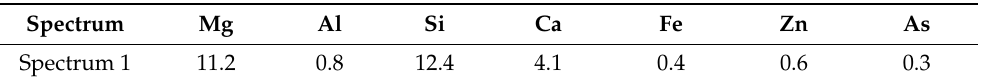
Table 3. Elements detected through EDS analysis of the areas shown in Figure 6a. Results are reported in weight percentage (w%) removing the counts of oxygen and carbon.